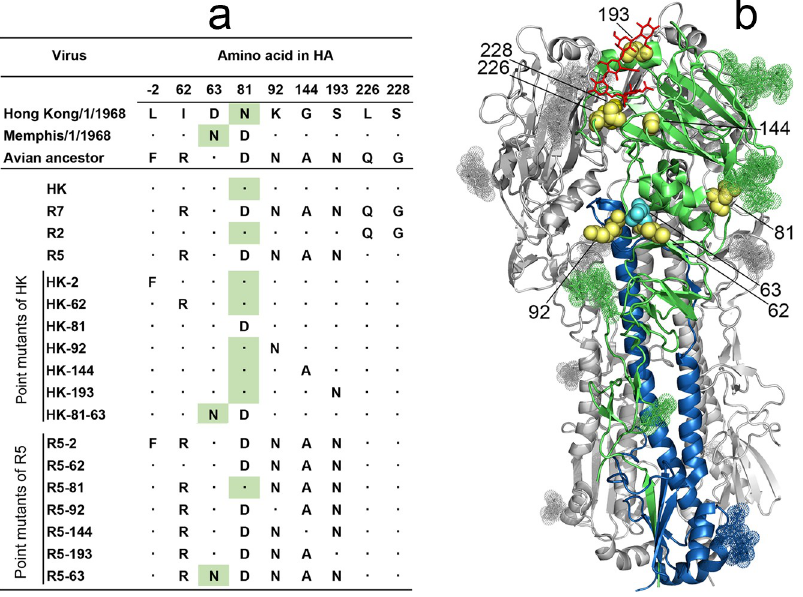
Fig 1. HA sequences and designations of 2:6 recombinant IAVs used in this study. ( a ) Amino acid differences between HAs of two 1968 pandemic virus lineages, their putative avian ancestor and 2:6 recombinant PR8-based viruses. Dots depict sequence identity with the HA of A/Hong Kong/1/1968. Numbering of amino acid positions starts from the N-terminus of the mature protein. Green background marks asparagine residues of glycosylation sites 63–65 and 81–83. ( b ) Location of amino acid substitutions shown as yellow space-filling models on the X-ray structure of the H3 HA complex with human receptor analogue LSTc (2YPG.pdb) [23]. Two HA monomers are colored gray, and the third monomer is colored green (HA1) and blue (HA2). LSTc is shown as red stick model, N-linked glycans are shown as dotted space-filling models. Cyan spheres show location of N 63 present in the HA of A/Memphis/1/1968 lineage. The model was generated using PyMOL 2.0.6 (Schro¨dinger, LLC).